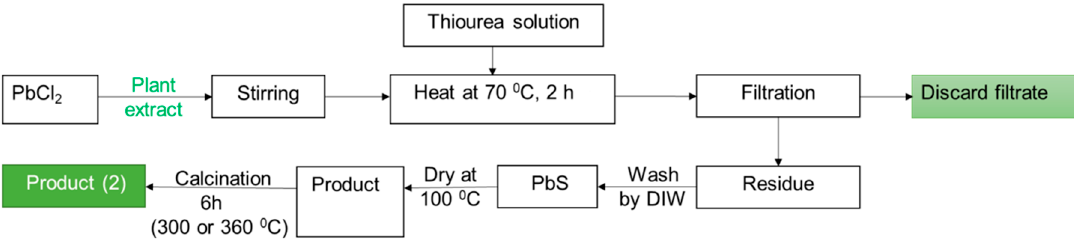
Figure 1. Flow chart for the synthesis of PbS nanomaterial using the Aloe Vera plant extract.